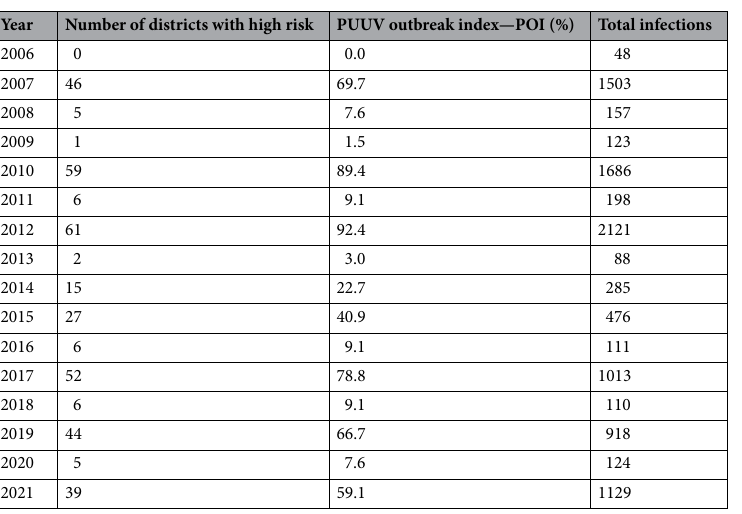
Table 1. The number of districts assigned high risk for each year from 2006 to 2021. The PUUV outbreak index (POI) was calculated by dividing by the total number of districts, i.e., 66. The POI values highly correlate with the total annual infections in the selected districts given in the last column, with 0.95 Pearson correlation coefficient and a p value of 1.15 × 10 −8 .